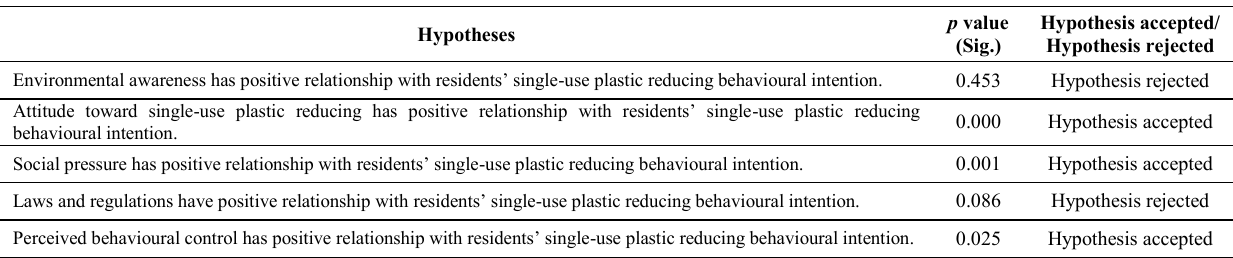
Table 6. Result of hypothesis testing with